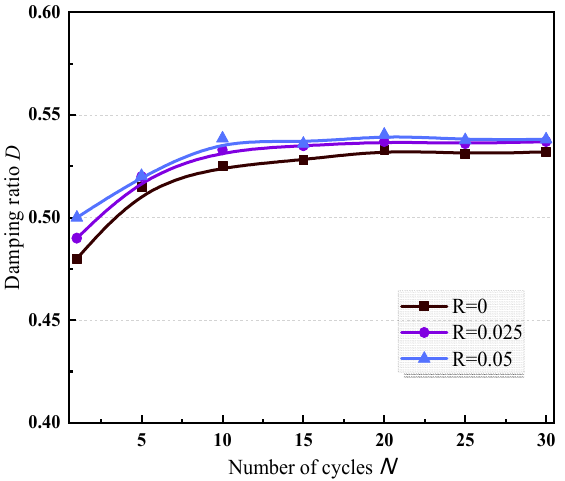
Figure 22. Damping ratio–cycle number curve under different roughness levels.